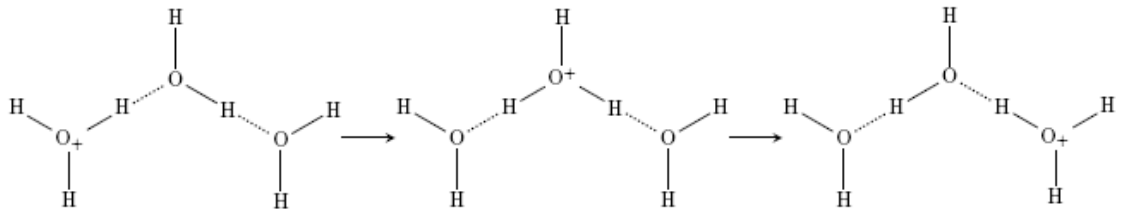
Figure 1. The transport of hydrogen ions (H + ) through water is accomplished by the Grotthuss mechanism, in which hydrogen bonds (dashed lines) and covalent bonds (solid lines) between water molecules are broken and